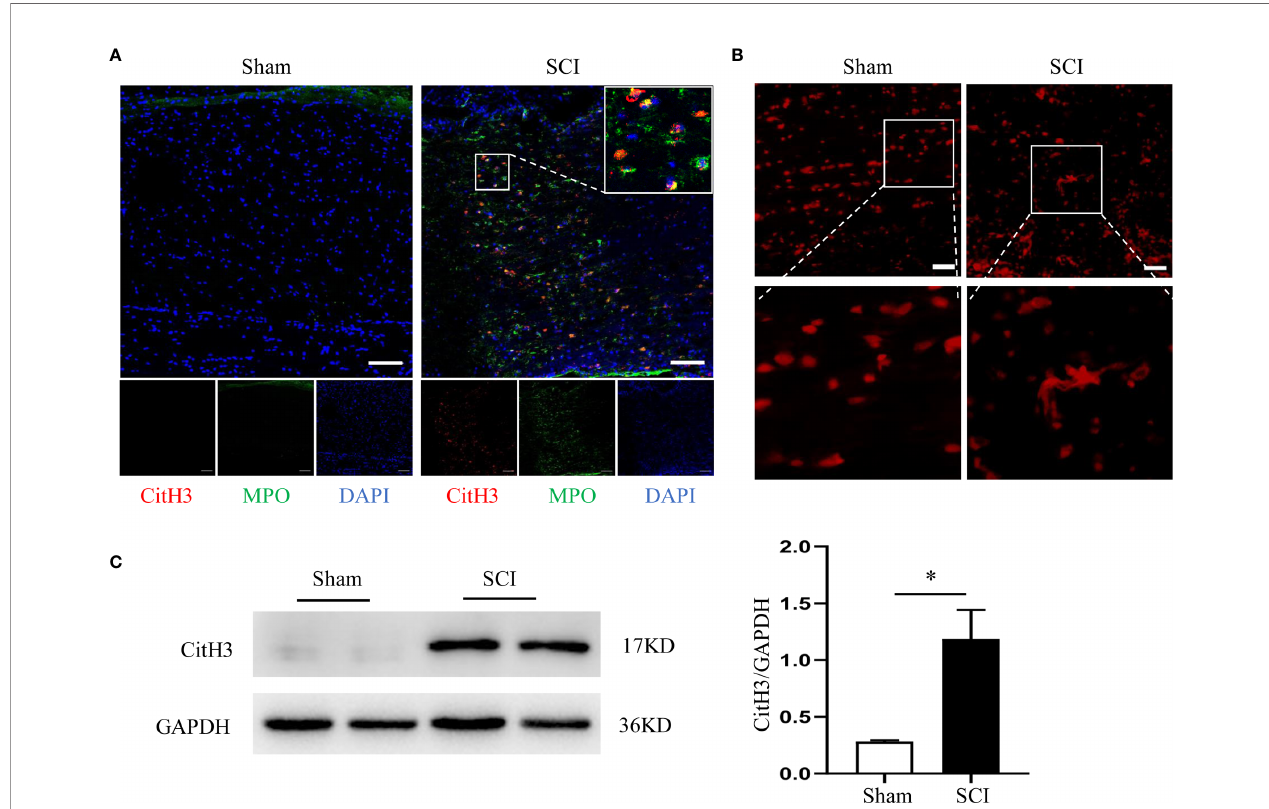
FIGURE 1 | In fi ltrated neutrophils produce NETs in the injured spinal cord. (A) Representative images of CitH3 (red) and MPO (green) double-positive cells in spinal cord from sham-operated rats and SCI rats at 24 h after operation. Nuclear was marked with DAPI (blue). Scale bars = 100 m m. (B) Representative images of network-like cell-free DNA structure by Sytox Orange staining. Scale bars = 200 m m. (C) Representative immunoblots and quanti fi cation of the CitH3 levels in spinal cord of rats subjected to SCI or sham operation. GAPDH is used as a loading control. Data are presented as means ± SD of n = 9 (* p <